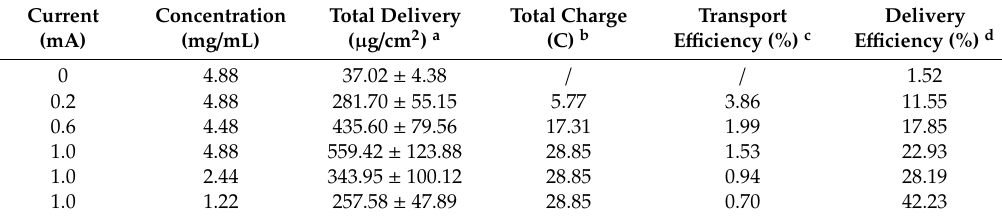
Table 3. Transport flux, transport e ffi ciency and delivery e ffi ciency under di ff erent conditions ( n =